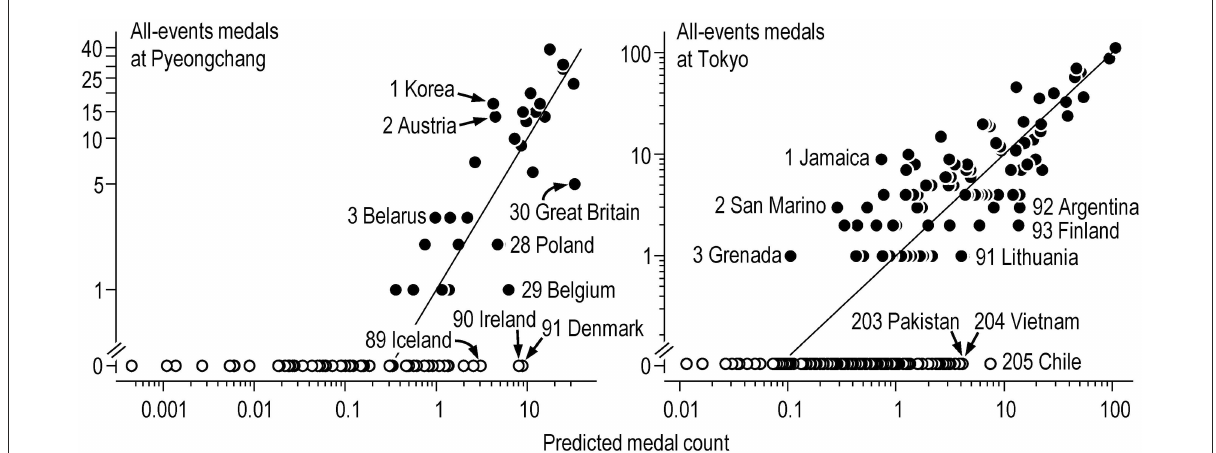
FIGURE2 All-events medal counts and medal counts predicted by the Poisson regression model at the Pyeongchang and Tokyo Paralympics. Filled and open symbols are values for individual nations that won respectively at least one medal and no medals. For nations that won medals, the numbers on the labels represent the ranking based on the medal count as a factor of the predicted medal count (the vertical distance between the actual and predicted medal count, represented by the line of identity, in these log-log graphs). Ranking of nations that won no medals is based on the predicted medal count. Labels indicate the best three medalists, the worst three medalists, and the worst three non-medalists.